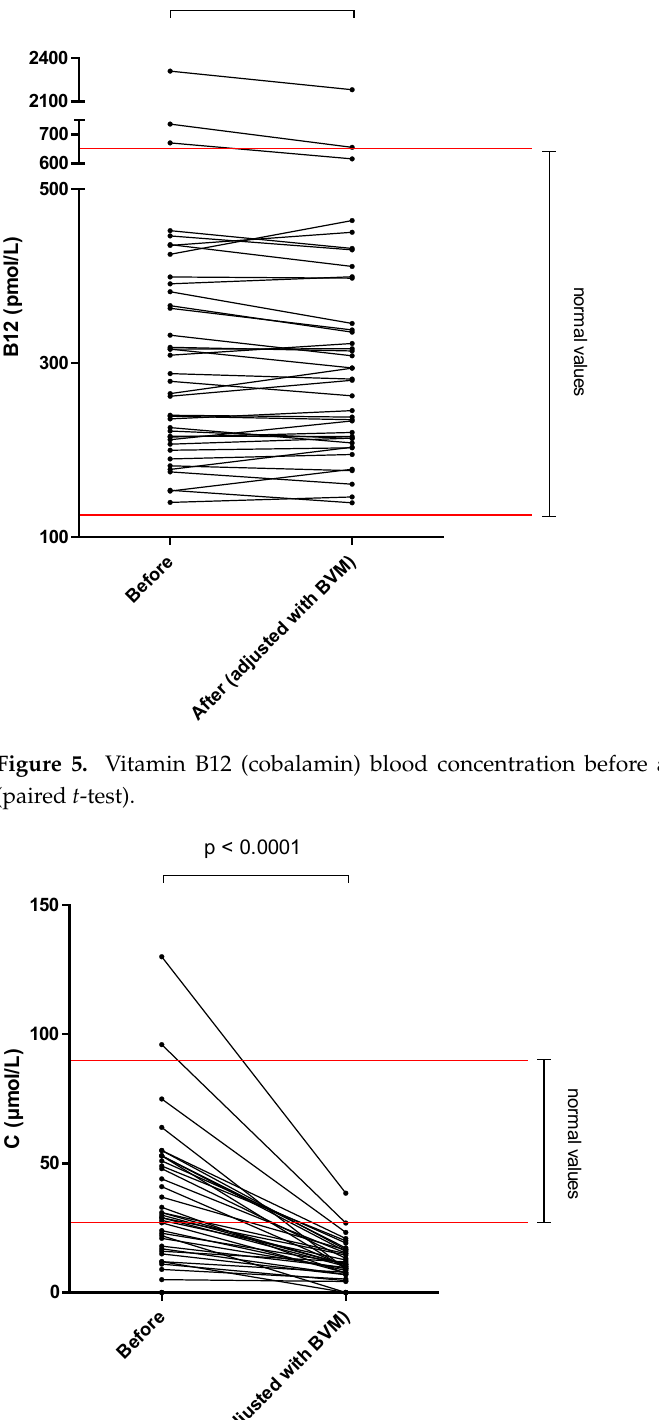
Figure 4. Vitamin B9 (folates) serum concentration before and after one 4 h-HDF session (paired t- test).